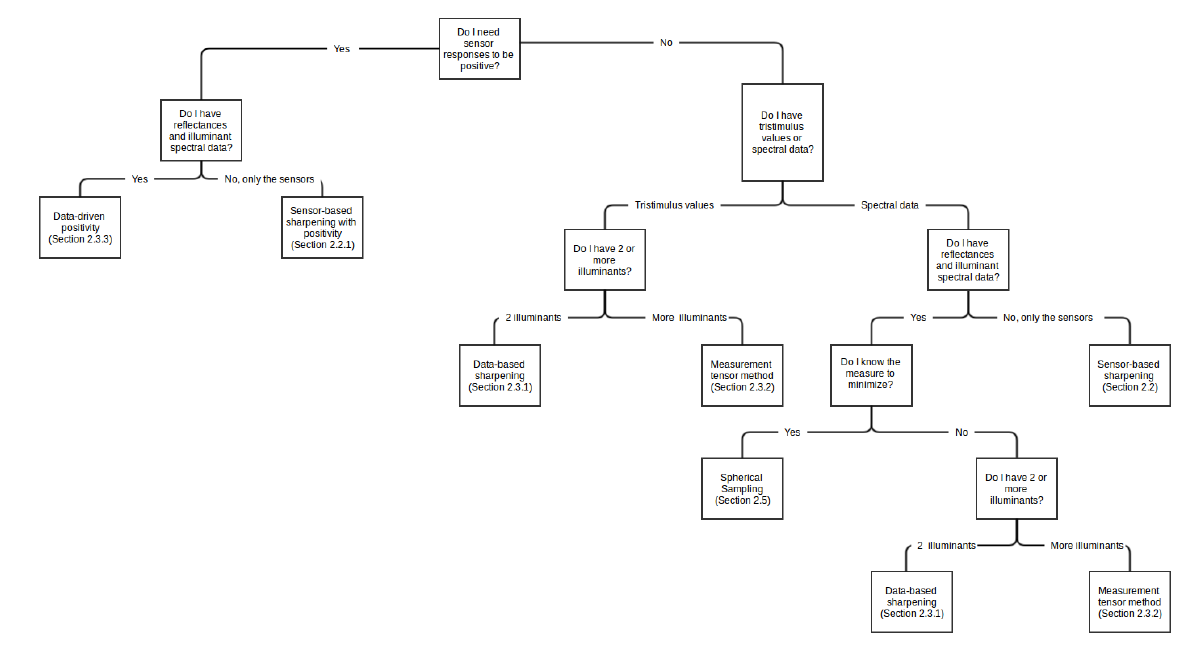
Figure 4. Hierarchy for the selection of a spectral sharpening method. The decision should take into account two aspects: the final goal pursued and the availability of spectral